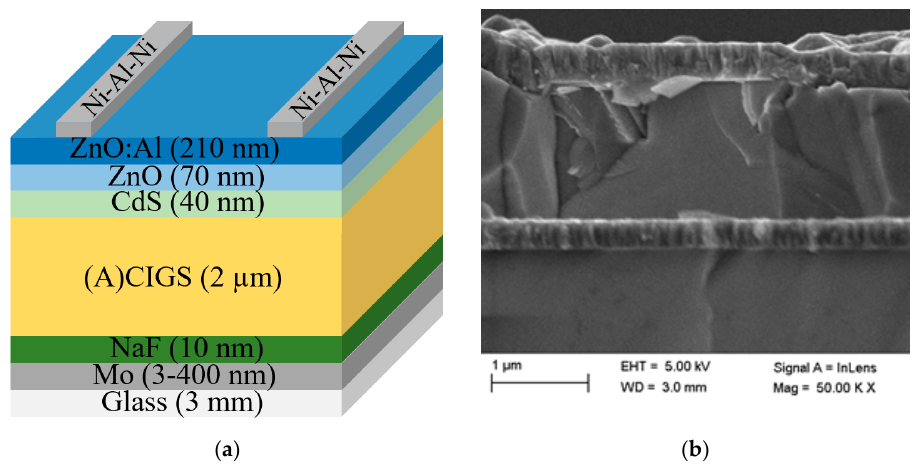
Figure 3. ( a ) Schematic picture of the ((Ag),Cu)(In,Ga)Se 2 ((A)CIGS) p–n-heterojunction with ZnO:Al using a CdS buffer layer (layers not in relative scale) and ( b ) cross-section SEM picture of the stack.